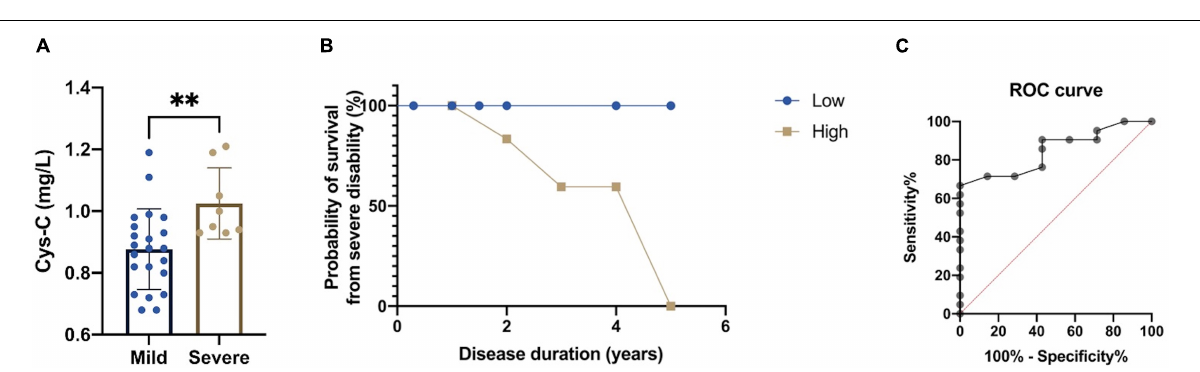
FIGURE 4 | Evaluation of the predictive value of the serum levels of Cys-C in MSA-C patients. (A) A comparison of serum Cys-C levels between MSA-C patients with severe disability and those with mild disability (1.03 ± 0.13 vs. 0.88 ± 0.12 mg/L, p = 0.009). (B) Kaplan-Meier analysis of the 5-year probability of survival from MSA-C patients with severe disability when compared between those with high levels of Cys-C and those with low levels of Cys-C (Log-rank test: X 2 = 4.154, p = 0.042). (C) ROC curve for serum Cys-C levels when predicting disease severity of patients with MSA-C (AUC = 0.847). The symbol ns is for P > 0.05, * for P < 0.05, ** for P < 0.01, and *** for P < 0.001,